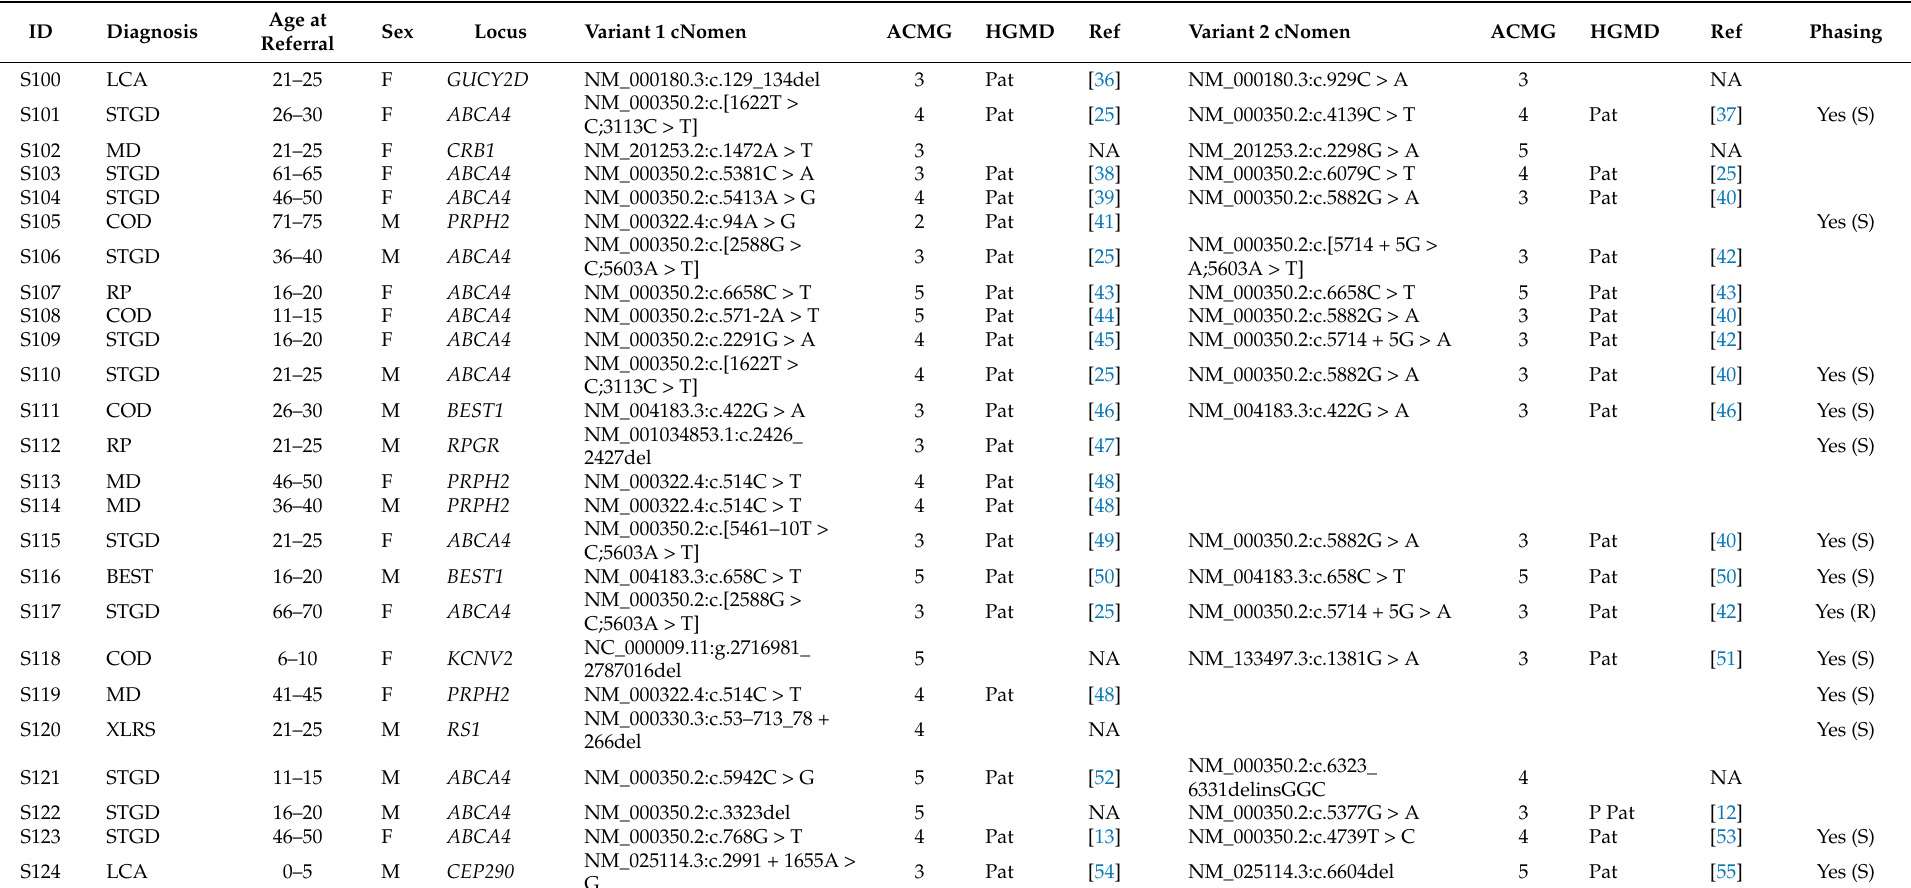
Table A1. Validation cohort findings. Abbreviations: ID, index patient ID; cNomen, Human Genome Variation Society (HGVS) cDNA-level nucleotide change nomenclature; HGMD, Human Gene Mutation Database; ACMG, American College of Medical Genetics and Genomics guidelines; F, female; M, male; Pat, pathogenic; P Pat, possibly pathogenic; Ass, association; Ref, reference; NA, not applicable; S, segregation; R, read